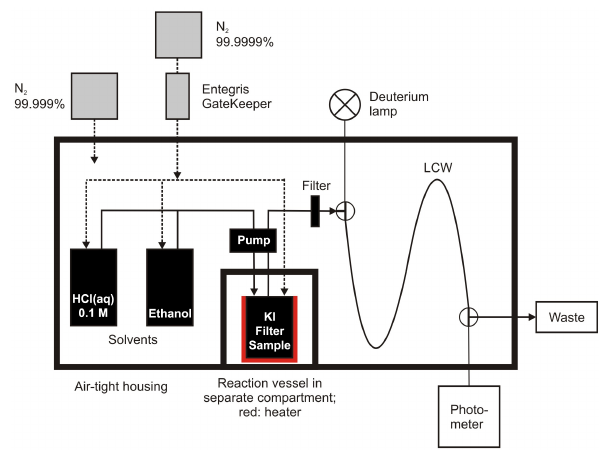
Fig. 1. Setup of the Peroxide-LOPAP. All tubings, fittings, vessels and the pump are positioned in an air-tight PVC housing under a ni- trogen atmosphere (99.999%). To position the reaction vessel into the analyser only that compartment has to be opened. Adding sol- vents into the reaction vessel as well as the triiodide solution into the LCW, the analyser has not to be opened. Before use, each solvent is purged of oxygen by bubbling with nitrogen (99.9999%) cleaned with a gas purifier (Entegris,